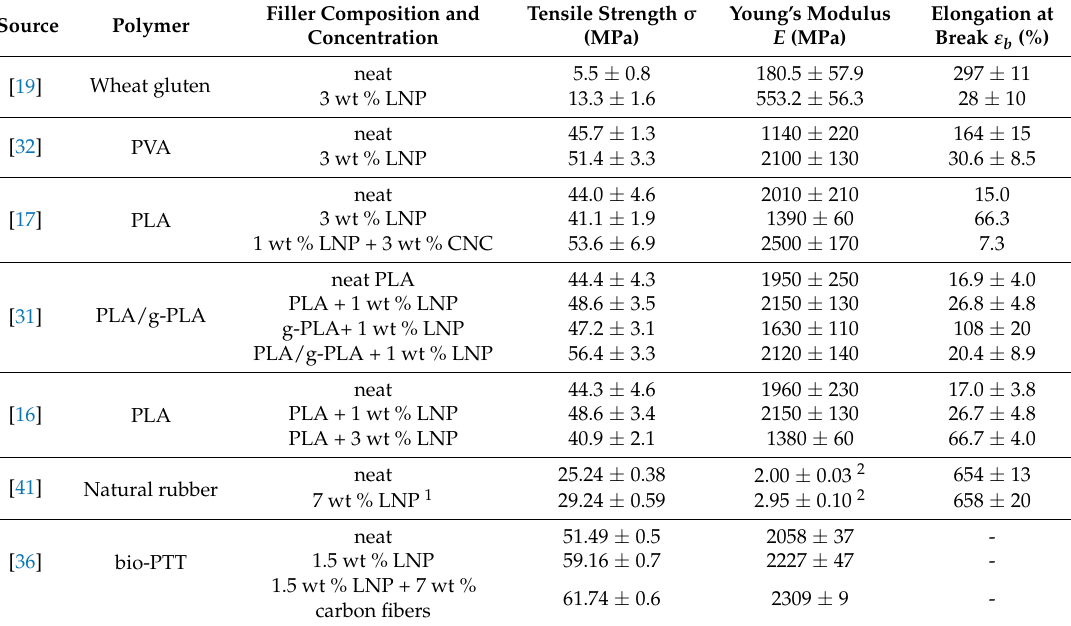
Table 2. Mechanical properties of different neat polymers in comparison to their